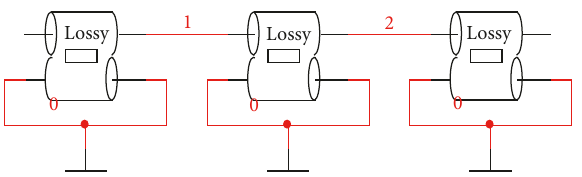
Figure 3: Equivalent circuit model of three cascaded dissipative acoustic layers.